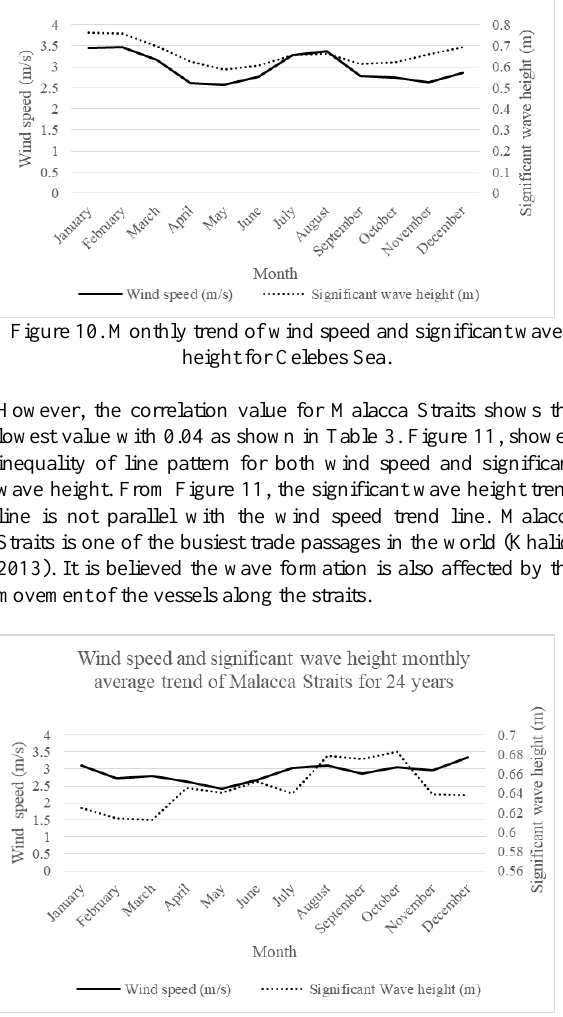
Figure 11. Monthly trend of wind speed and significant wave height for Malacca Straits.